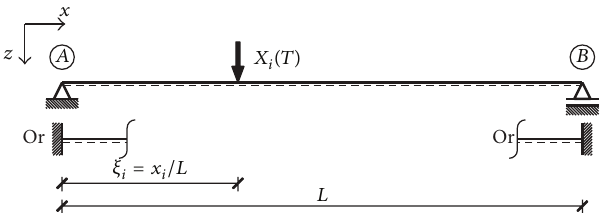
Figure 5: A single-span beam subjected to a time-varying concen- trated force.